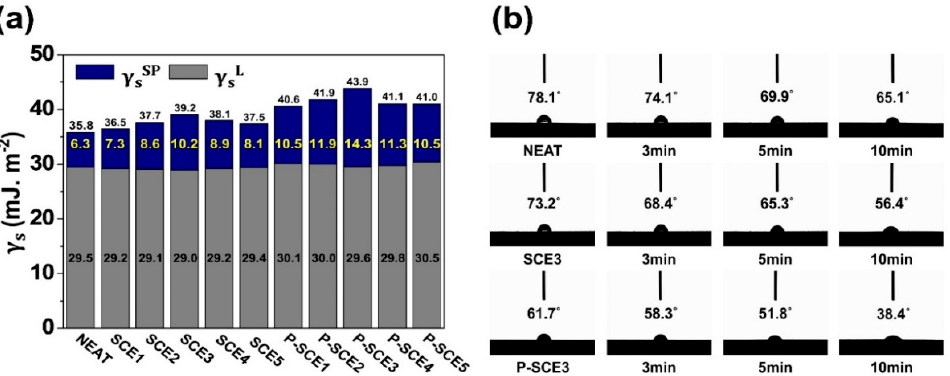
Figure 4. ( a ) Surface free energy and ( b ) optical image of contact angles with distilled water over-